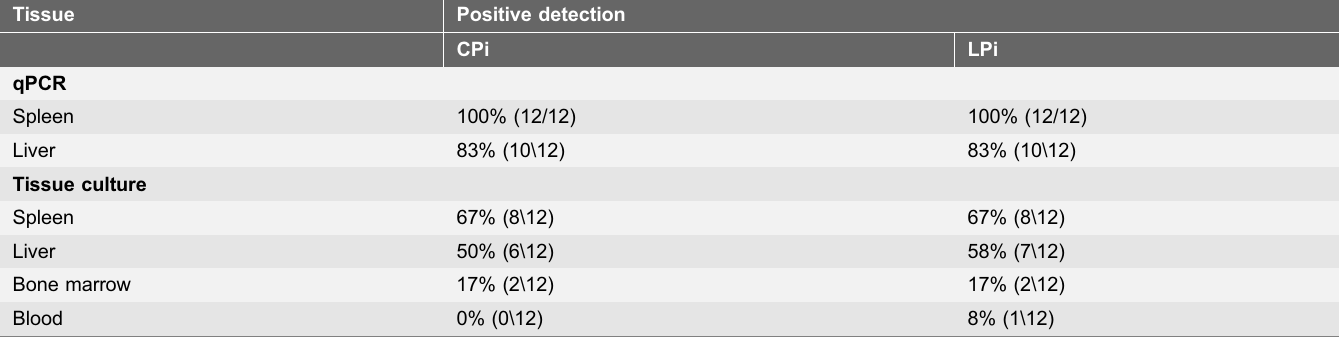
CPi: animals fed 14% protein diet and infected; LPi: animals fed 4% protein diet and